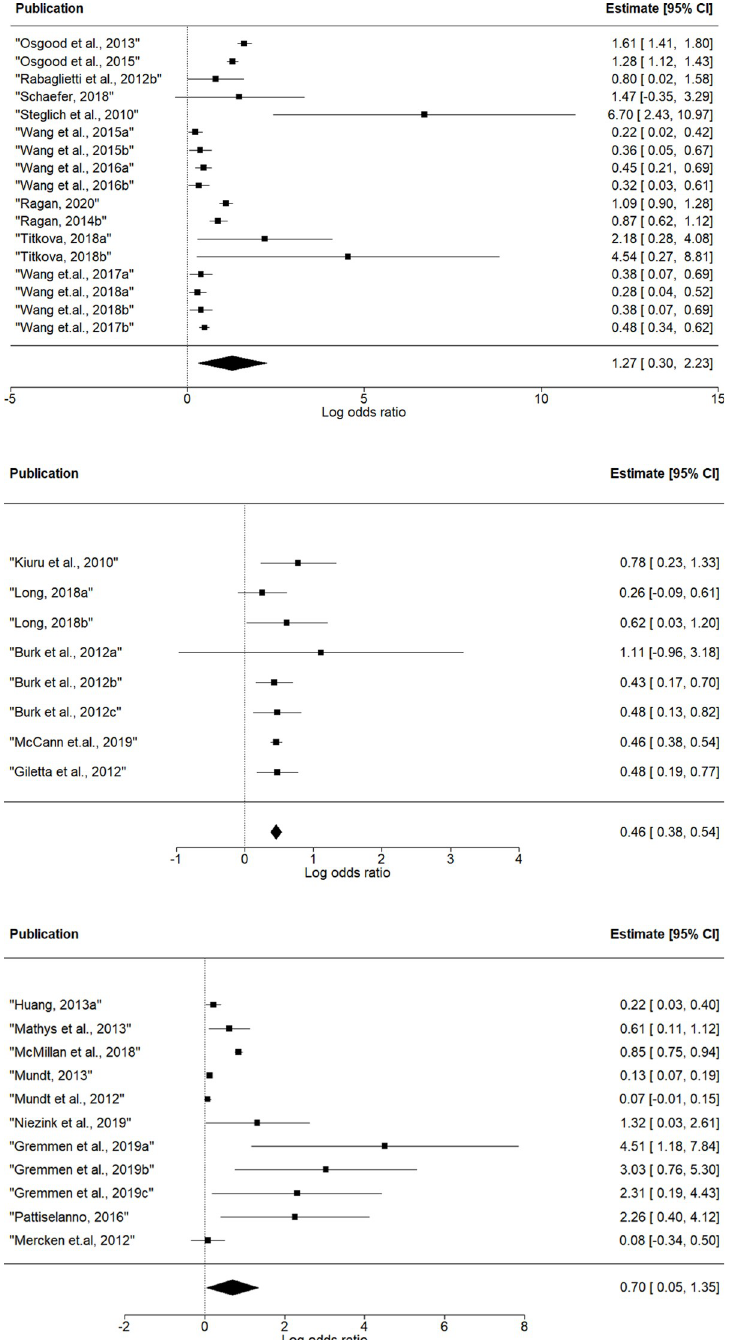
Fig 2. Forest plots of effect size estimates for peer influence effects: (a) avSim, (b) totSim, (c)